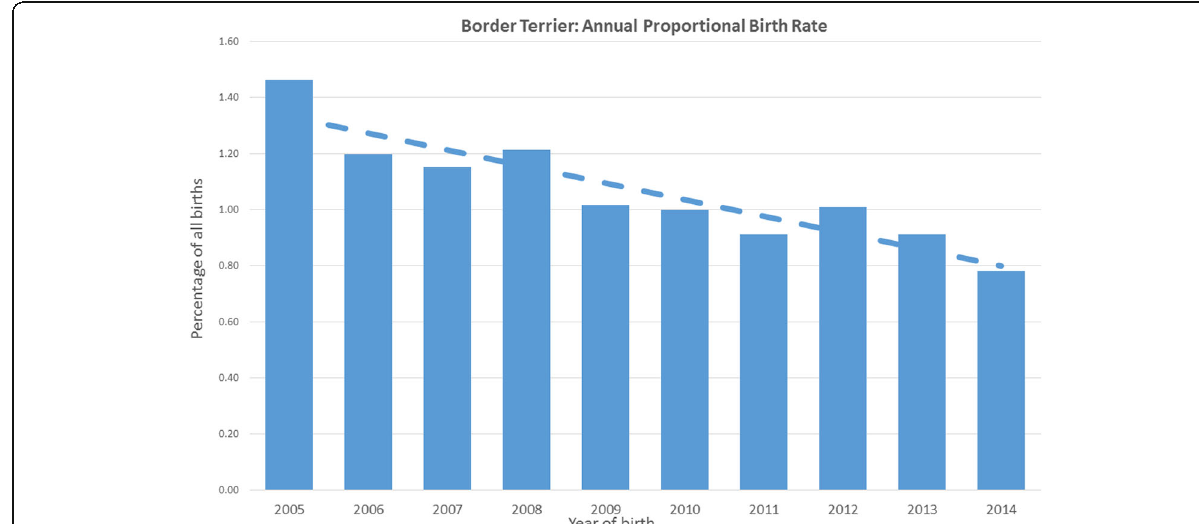
Fig. 1 Annual birth proportion (2005 – 2014) for Border Terriers among all dogs under primary veterinary care at clinics in England within the VetCompass ™ Programme ( n =